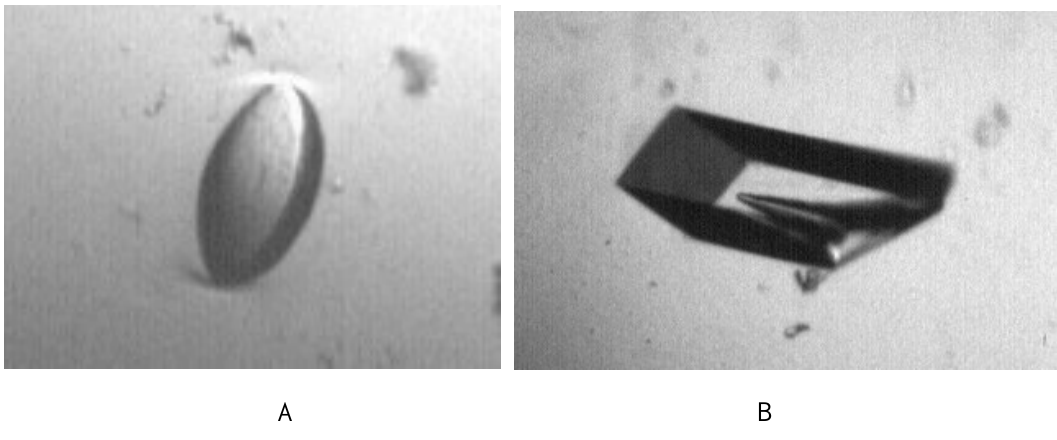
Figure 1. Images presenting morphology for both crystal forms: (A) crystal form